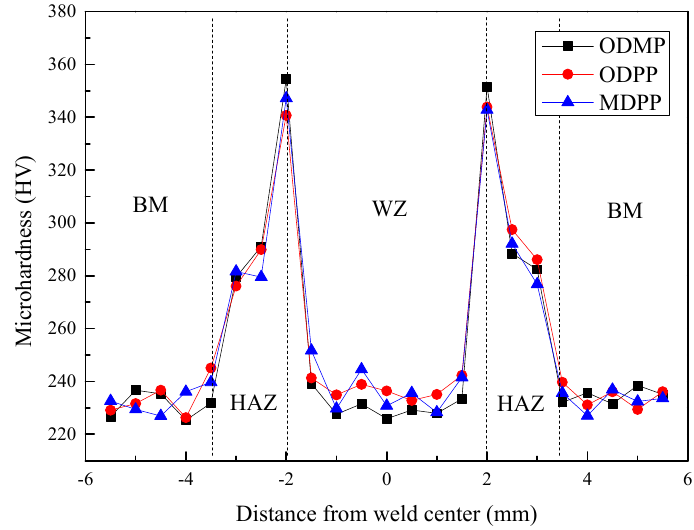
Figure 6. The microhardness of the welded joints with three typical modes of droplet transfer (BM: base metal; HAZ: heat-affected zone; WZ: weld zone).